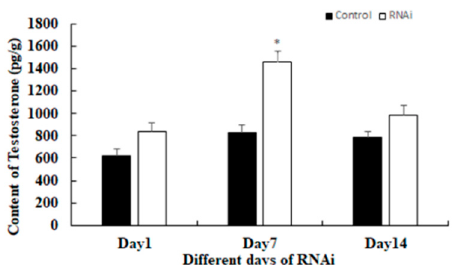
Figure 8. Measurement of the content of testosterone at different days after Mn-GEM dsRNA injection. Data are shown as mean + SD (standard deviation) of tissues from three separate individuals. * indicates significant expression difference between the RNAi group and control group at the sample day.